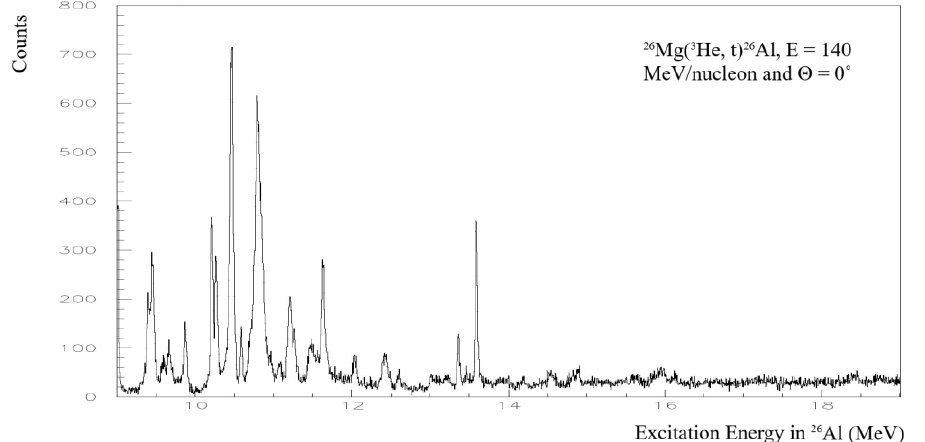
Fig. 4 The energy spectrum of the 26 Mg( 3 He, t) 26 Al reaction E x between 9 MeV and 19